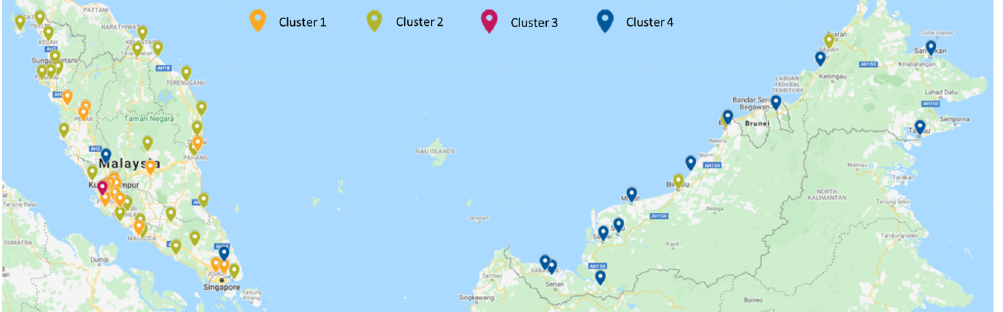
Figure 11. Air monitoring stations’ locations colored according to clusters for PM 10 daily average time series data with DTW and agglomerative hierarchical as its clustering algorithm.